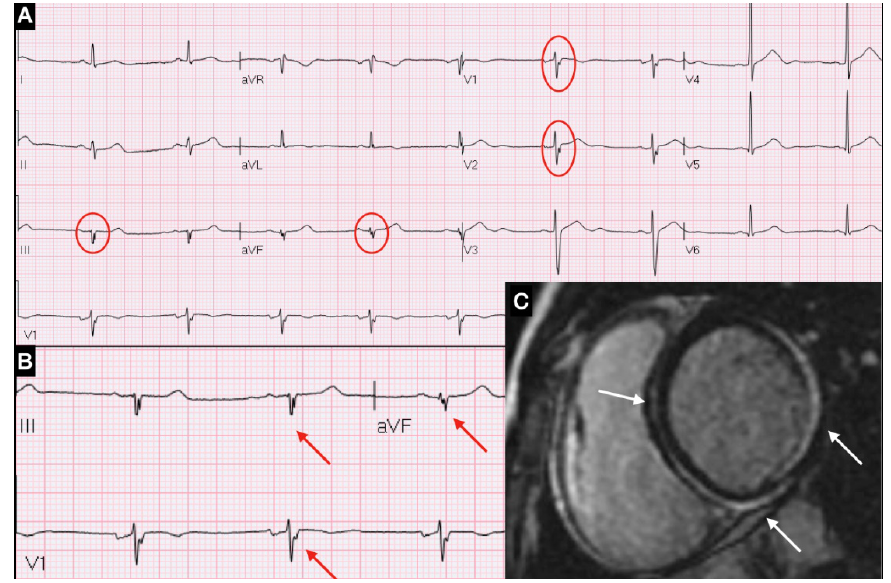
Figure 1. ( A ) ECG showing fQRA in leads V1, V2, DIII and aVF; ( B ) Magnification of fQRS; ( C ) CMR short-axis view with LGE in inferior-lateral and septal areas.